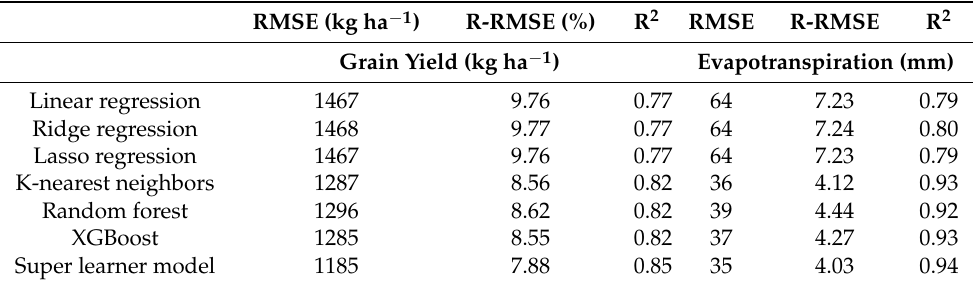
Table 4. Evaluation metrics for various machine learning algorithms built to predict maize yield and evapotranspiration for the testing dataset (1991, 1998, 2002, 2005, 2010, 2013, and